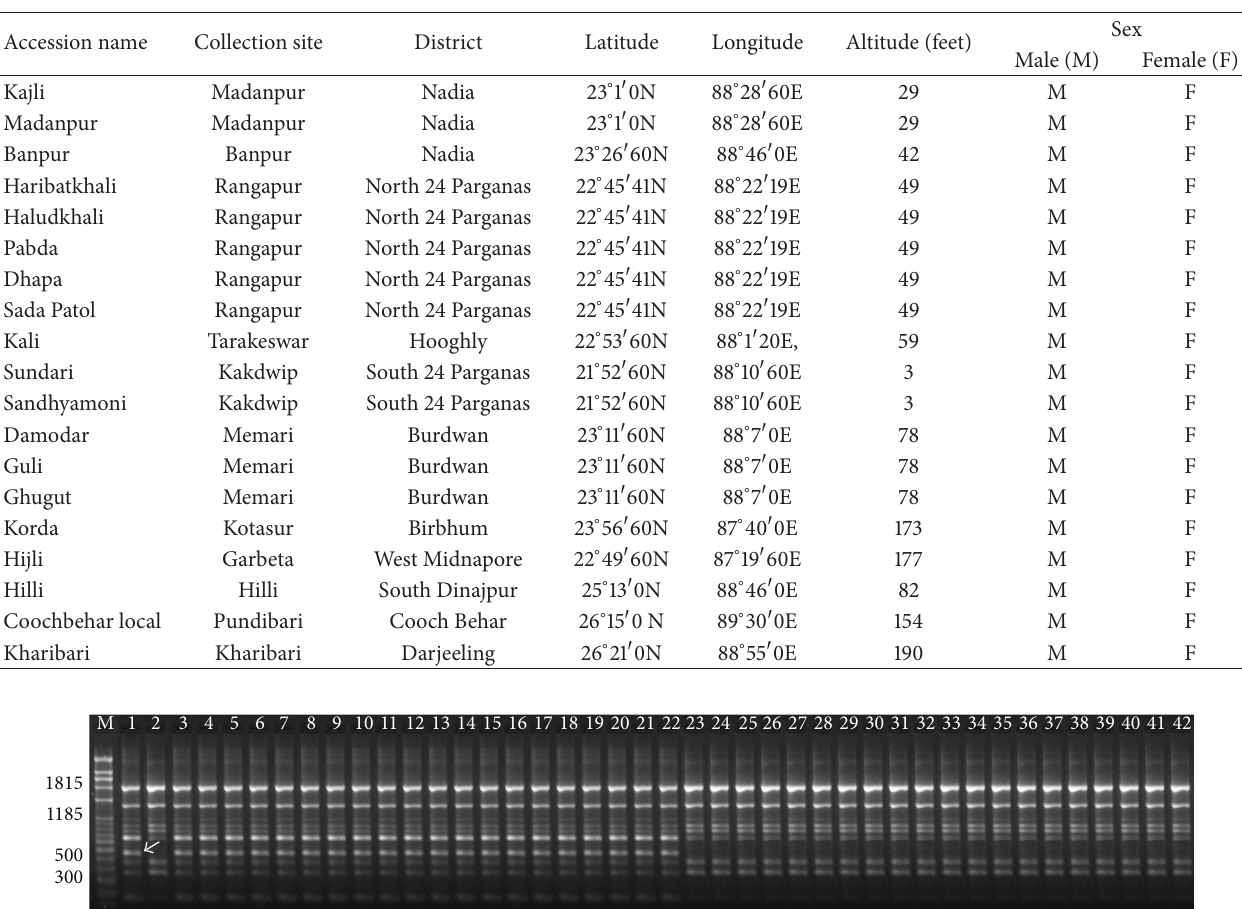
Table 1: Pointed gourd accessions collected from different locations of West Bengal, India.